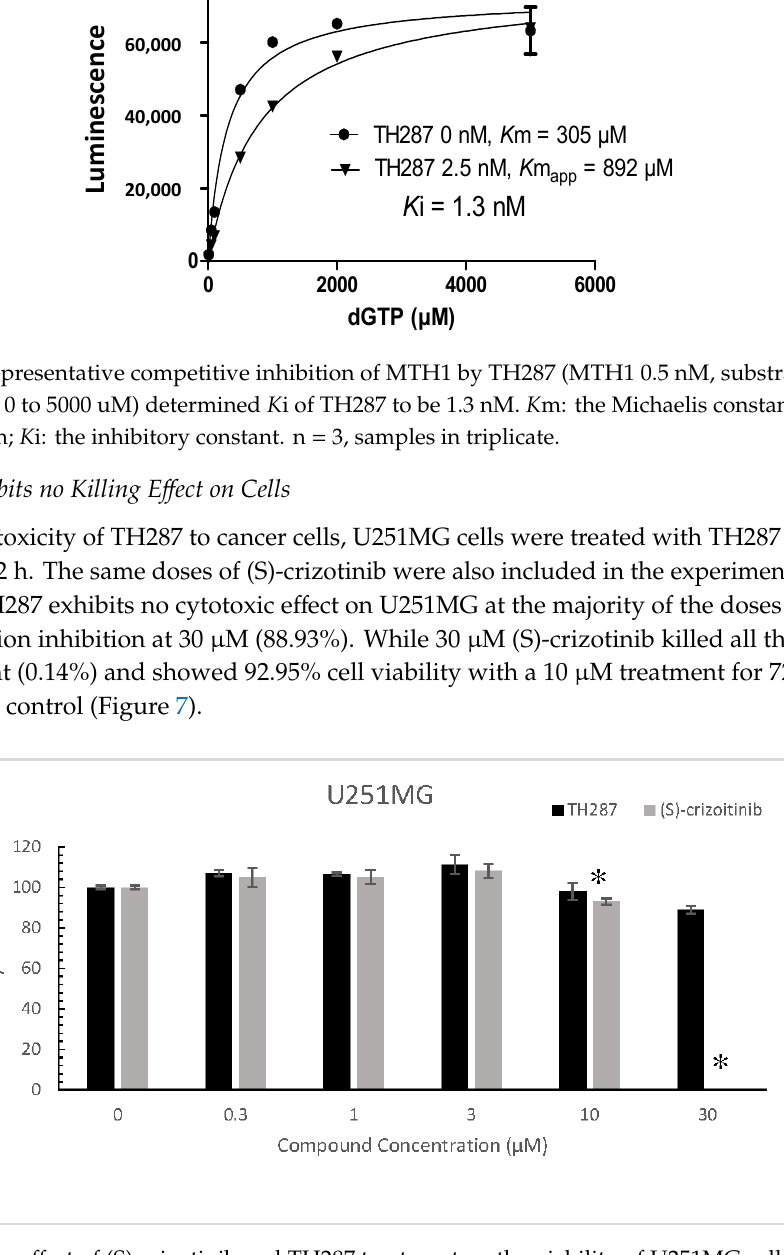
Figure 7. The effect of (S)-crizotinib and TH287 treatment on the viability of U251MG cells by MTT assay. U251MG cells were treated with increasing concentrations of (S)-crizotinib or TH287 (range: 0~30 µM) for 72 h, MTT assays were then performed. One Way ANOVA and Dunnett’s Multiple Comparison test were adopted for significance analysis. In assessing the significance of comparisons a p -value p < 0.05 was considered significant. *, p < 0.05. n = 3, samples in triplicate.